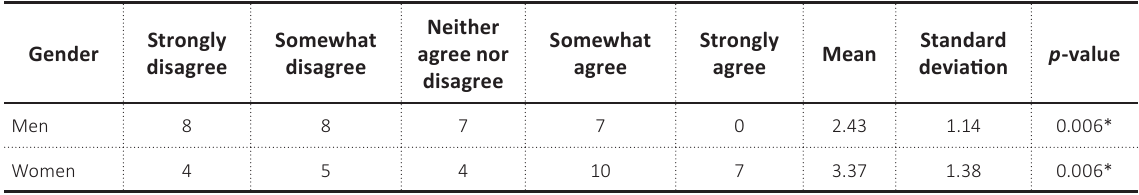
Table 3. I sometimes feel my job is meaningless